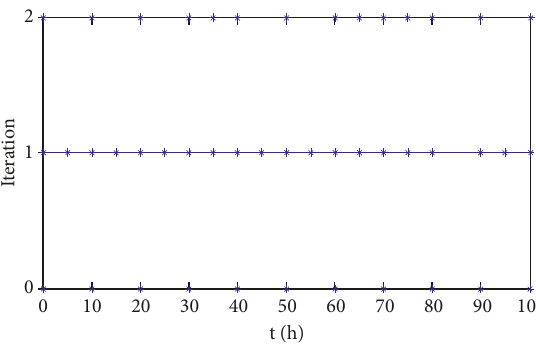
Figure 1: Evolution of the time grids.